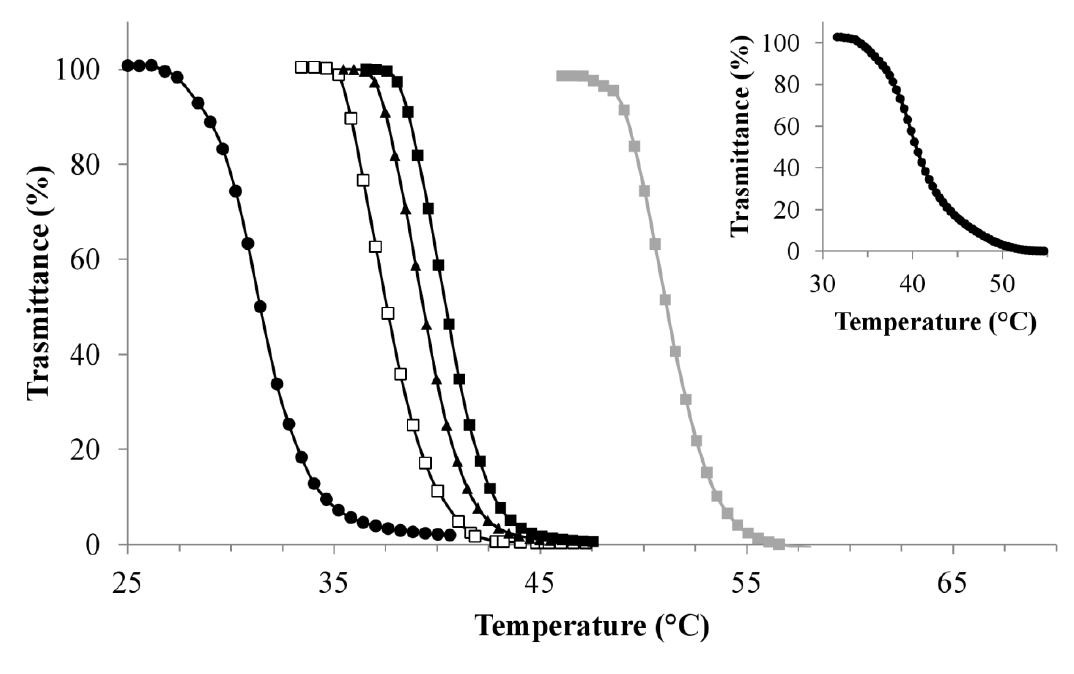
Figure 2. Phase transition behaviour of unfunctionalised polymer ( ■ ), 1 ( ■ ), 2 ( □ ), 3 ( ● ), 4 ( ▲ ) and 5 ( ● ) (inset). (Polymer concentration used = 1